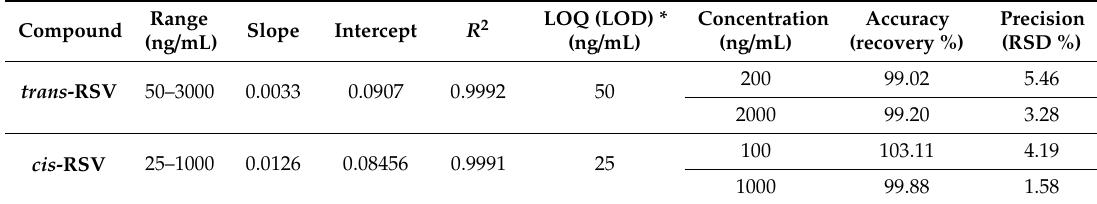
Table 1. Validation